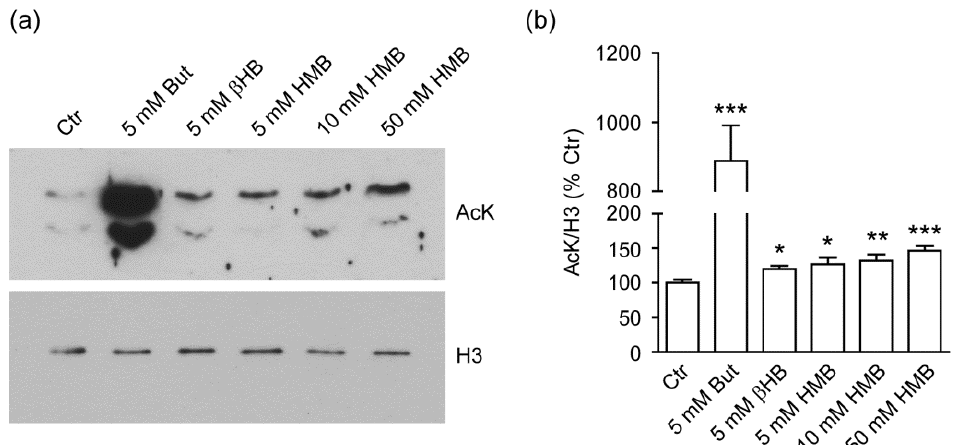
Figure 1. ( a ) Representative immunoblot analysis of acid-precipitated histones from undifferentiated C2C12 cells treated for 18 h with Butyrate (But), β -Hydroxybutyrate ( β HB), or increasing concentrations of β -Hydroxy- β -Methyl Butyrate (HMB). An anti pan acetyl-lysine (AcK) antibody was used to assess global histone acetylation (upper panel); total histone H3 (lower panel) was used as loading control; ( b ) Densitometry of acetylated histone bands. Columns are mean ± SEM of OD values normalized for the untreated sample (% Ctr); n = 6 independent experiments. * p < 0.05; ** p < 0.01, *** p < 0.001 versus Ctr (untreated).